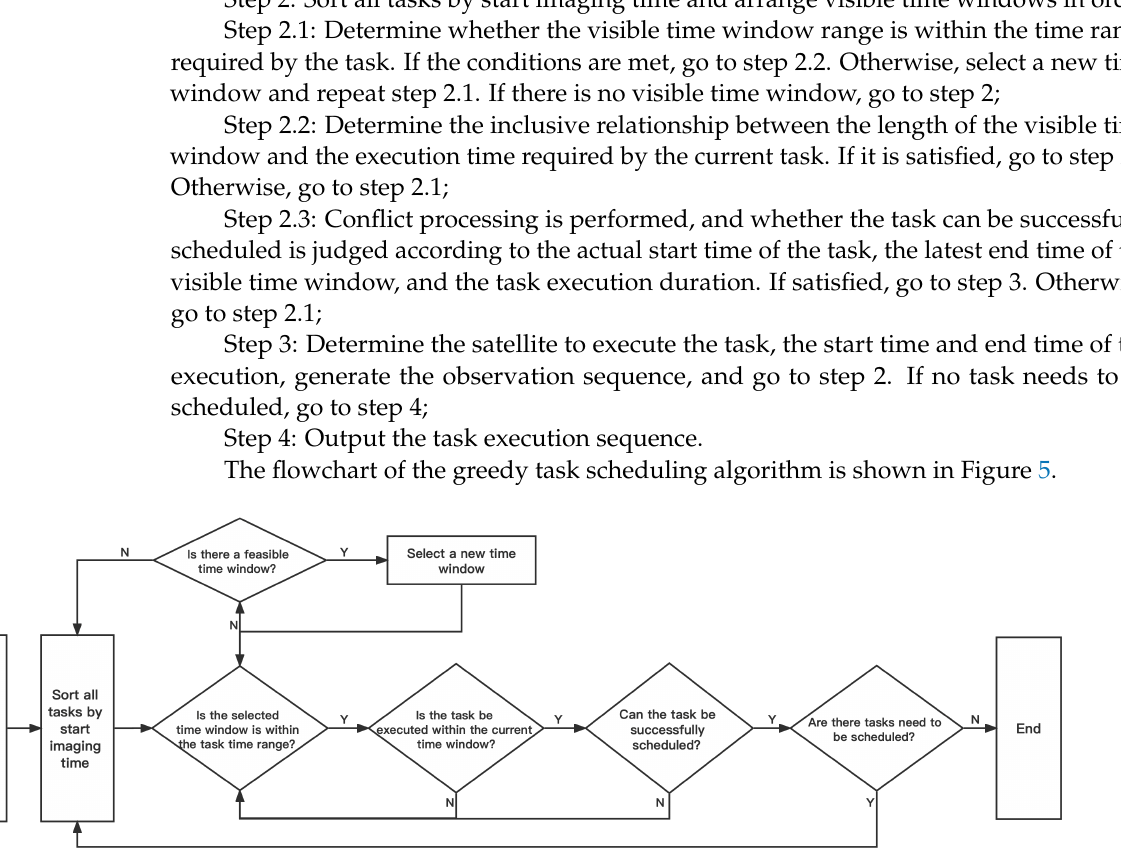
Figure 5. Flowchart of the greedy task scheduling